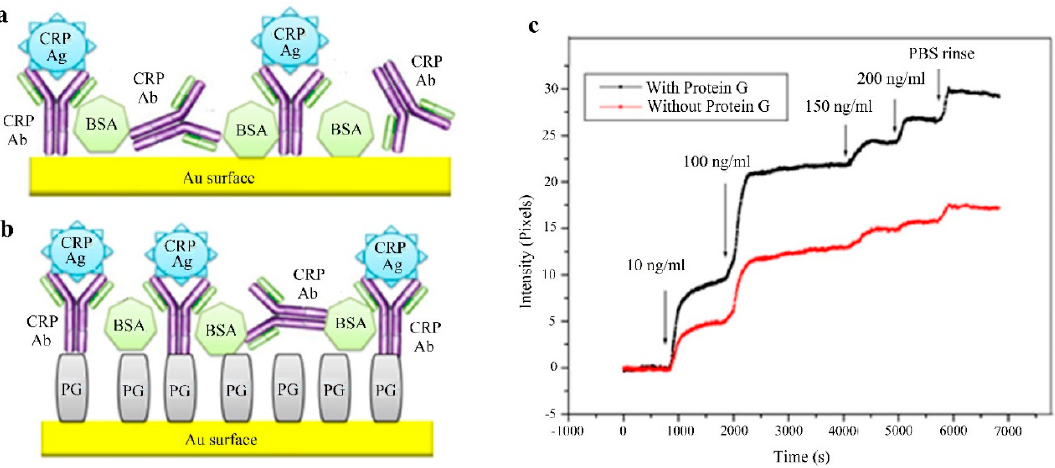
Figure 12. ( a ) Biosensor configuration without protein G. ( b ) Biosensor configuration with protein G.